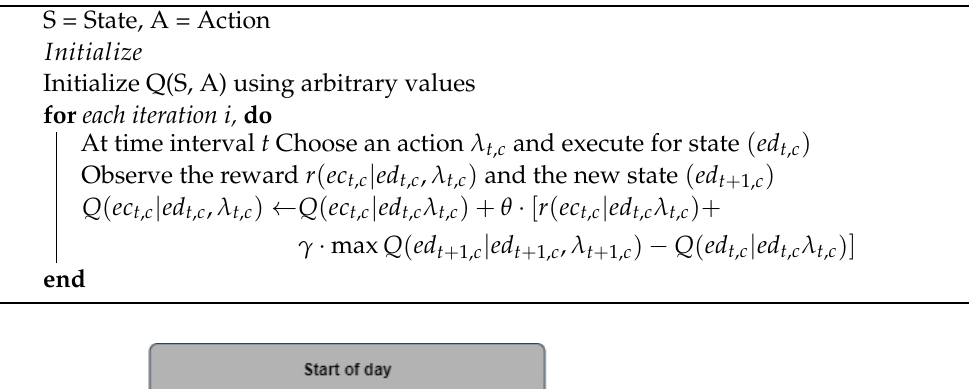
Algorithm 1: Proposed Q -learning algorithm